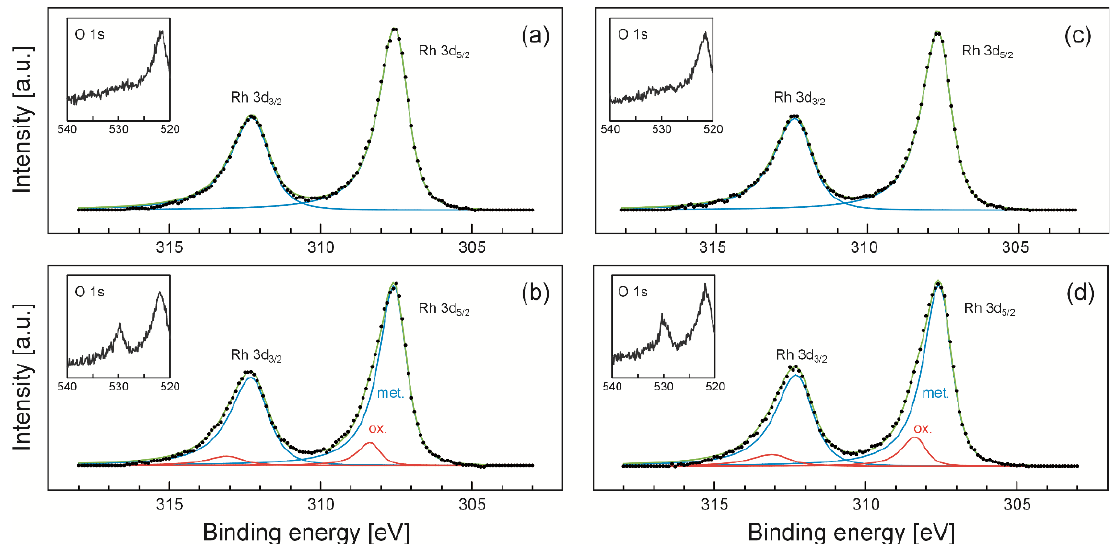
Figure 1. Rh 3d spectra: ( a ) from area (1) before oxidation; ( b ) from area (1) after 75 min of oxidation at 668 K; ( c ) from area (4) before oxidation; ( d ) from area (4) after oxidation at the same conditions as in ( b ); Oxygen signal is presented in the insets.